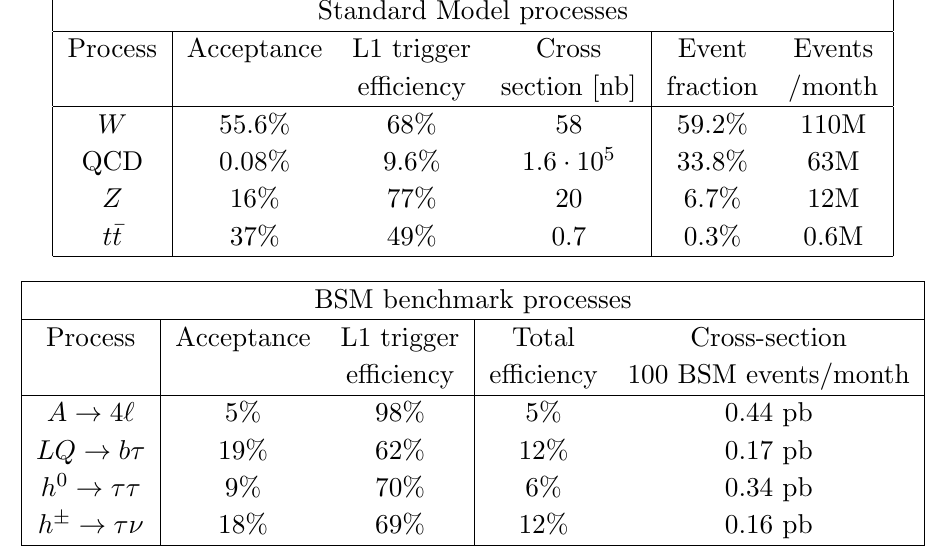
Table 1 . Acceptance and L1 trigger (i.e. p ‘ and Iso requirement) e(cid:14)ciency for the four studied SM T processes and corresponding values for the BSM benchmark models. For SM processes, we quote the total cross section before the trigger, the expected number of events per month and the fraction in the SM cocktail. For BSM models, we compute the production cross section corresponding to an average of 100 BSM events per month passing the acceptance and L1 trigger requirements. The monthly event yield is computed assuming an average luminosity per month of 5 fb (cid:0) 1 , corresponding to the running conditions discussed in section